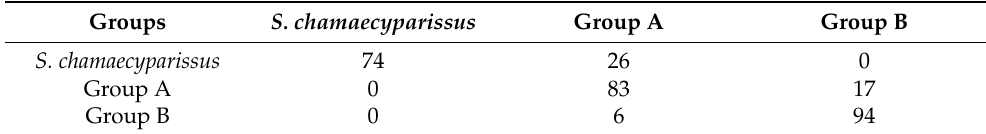
Table 10. Results of the Random Forest analysis applied to the two Santolina groups of affinity highlighted by the cypsela morpho-colorimetric analysis. Group A is composed of the populations of S. insularis from central-eastern Sardinia (Laconi, Monte Spada, and Monte Corrasi). Group B is composed of all the remaining populations of S. insularis and S. corsica , including type localities of both names. Values are percentages.